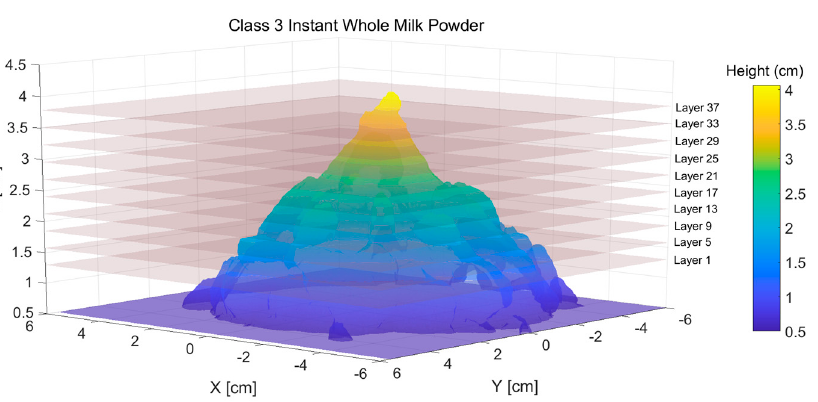
Figure 4. An oblique view of the triangulated model of a milk powder cone sliced at 40 equally spaced contours (only 10 slices are diagrammatically shown in this figure for clarity). spaced contours (only 10 slices are diagrammatically shown in this figure for